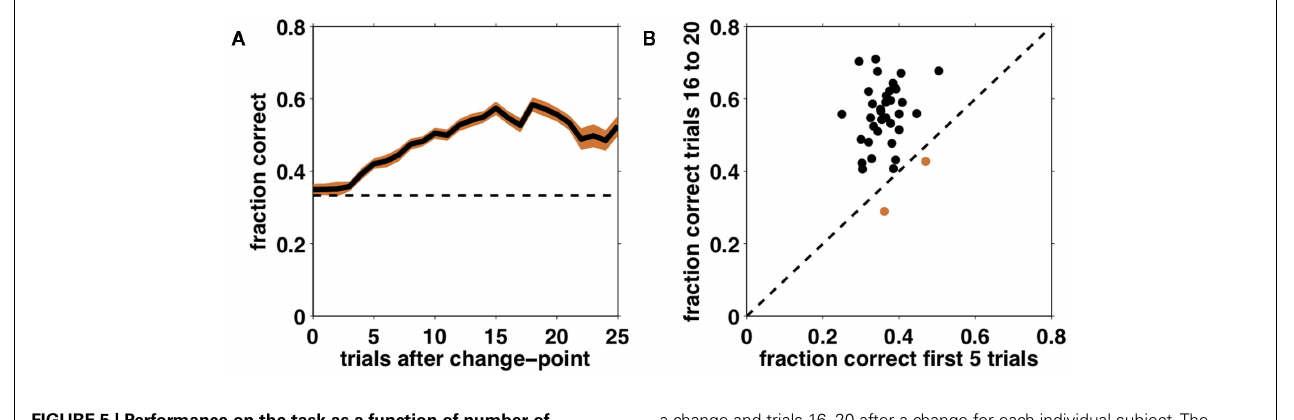
FIGURE 5 | Performance on the task as a function of number of trials after an unsignaled change-point. (A) Fraction correct choices as a function of trial number after a change-point, averaged across subjects (solid black line). Shading – SEM; dashed line – chance responding. (B) Comparison of average performance on trials 1–5 after